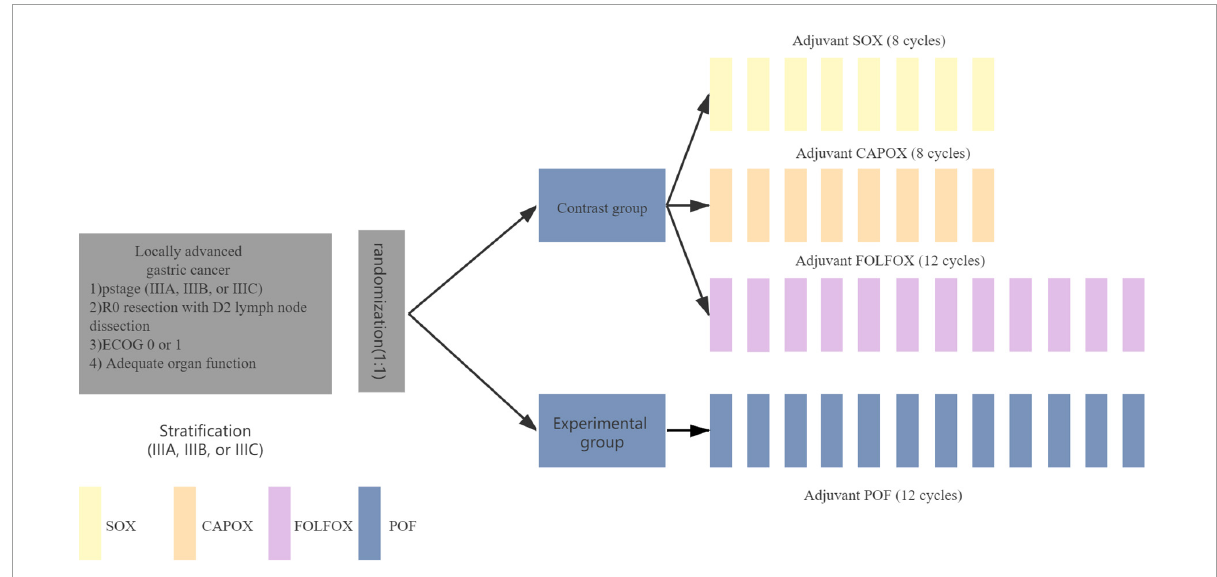
FIGURE2 Study treatment. SOX, oxaliplatin and S-1; CAPOX, oxaliplatin and capecitabine; FOLFOX, folinic acid (or leucovorin), 5-fluorouracil and oxaliplatin; POF, paclitaxel, folinic acid (or leucovorin), 5-fluorouracil, and